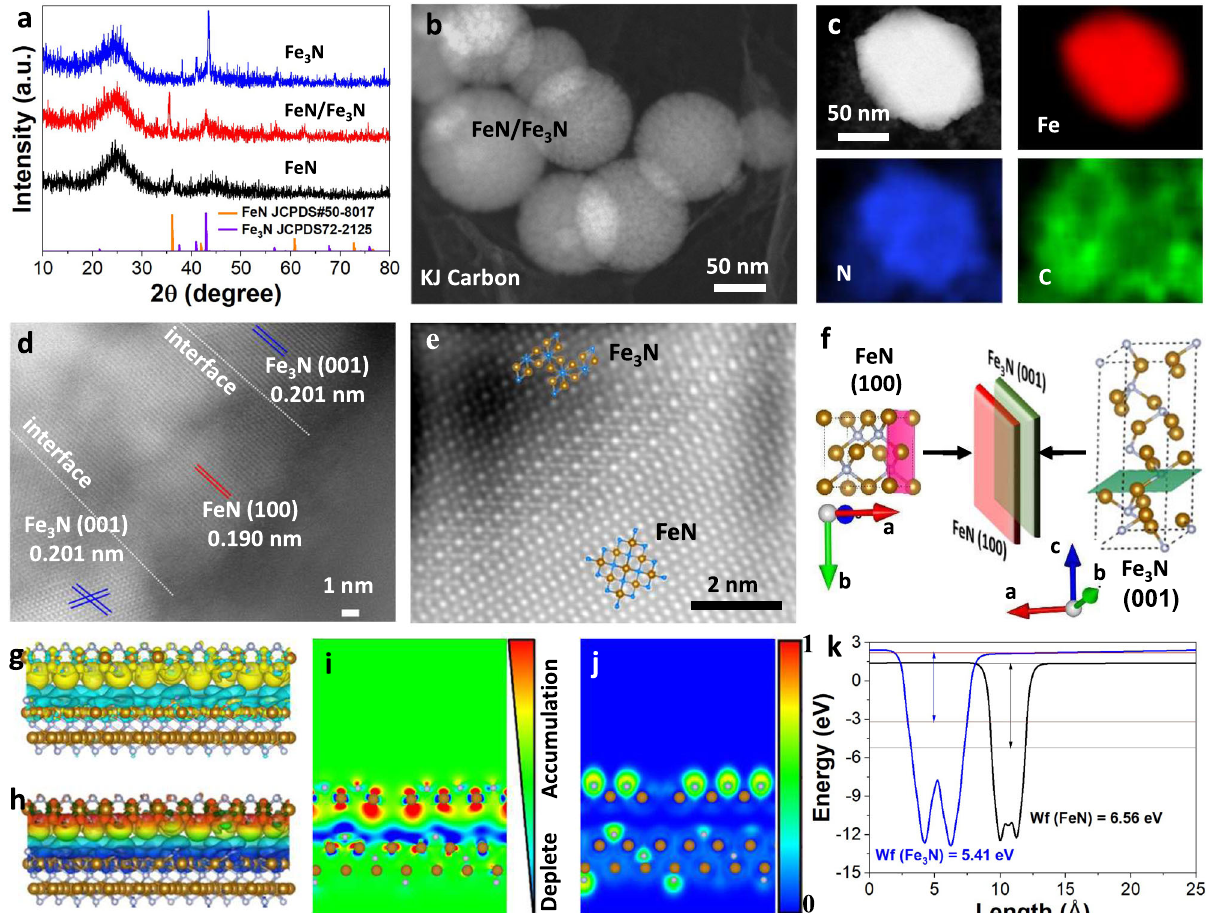
g 3D electron density difference distributions at the FeN/Fe 3 N interface. h The electrostatic potential of the FeN/Fe 3 N interface. i The electron localization func- tion of the FeN/Fe 3 N interface. j 2D cross-section of electron density difference at the FeN/Fe 3 N interface. k The calculated work functions (W f ) of FeN and Fe 3